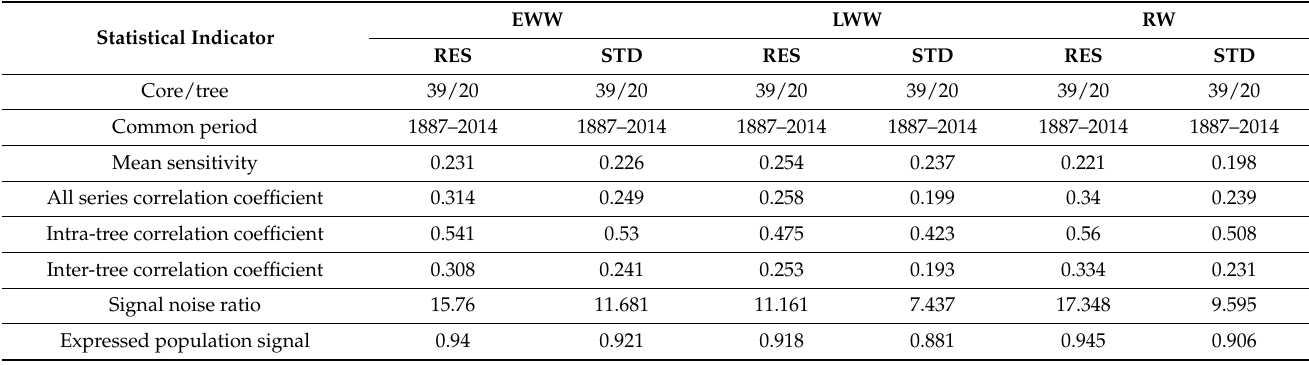
Table 1. The chronological statistics of EWW, LWW and RW of Pinus taiwanensis Hayata. Statistical